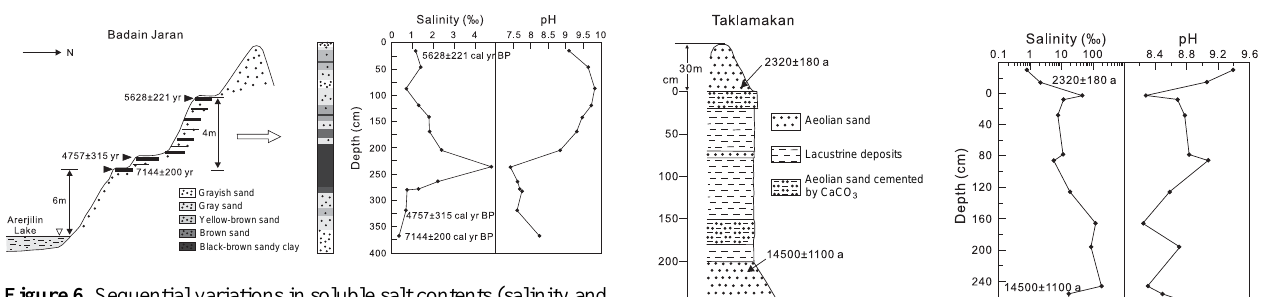
Figure 6. Sequential variations in soluble salt contents (salinity and pH) of the Arerjilin-I section in the Badain Jaran Desert.